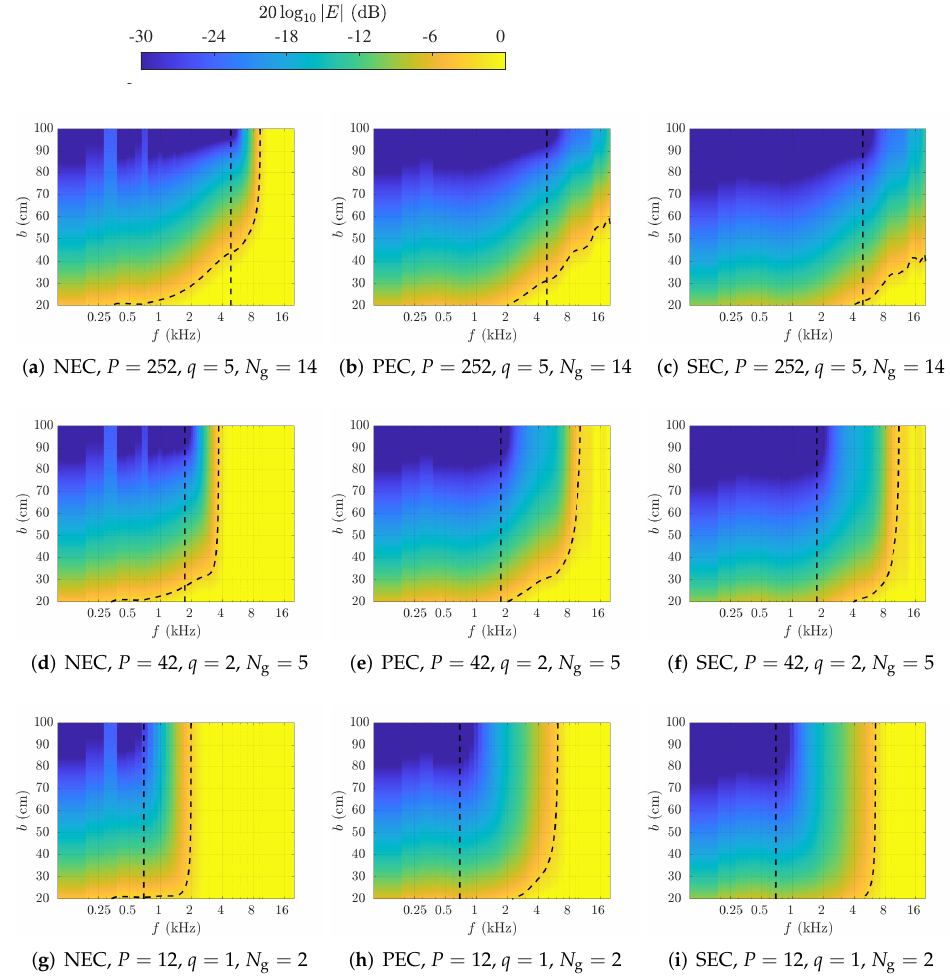
Figure 4. Synthesis error calculated with (20). Black-dashed curves indicate − 3 dB values. Black- dashed lines indicate f max in (16). Left column: NEC. Center column: PEC. Right column: